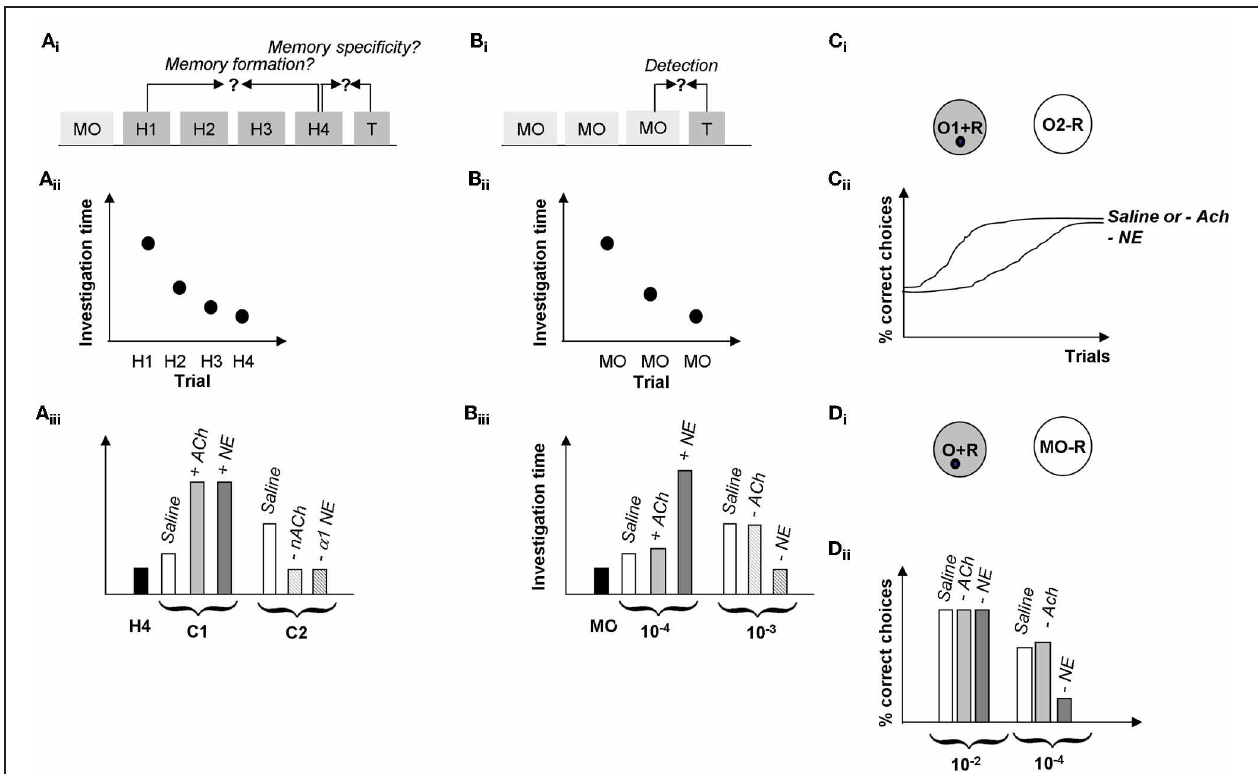
FIGURE 6 | Summary of behavioral results. (A) Spontaneous odor discrimination task. (A i ) Rats are first habituated to an odor during